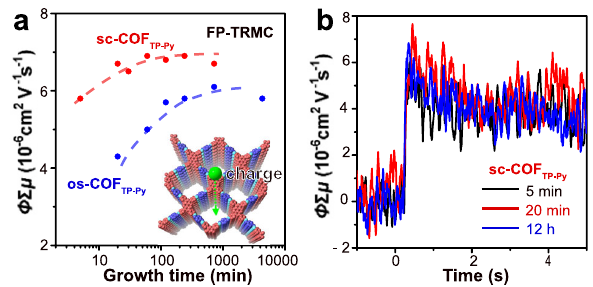
Fig. 6 FP-TRMC measurement. a Photoconductivity ( ϕ Σ μ ) of sc-COF TP-Py and os-COF TP-Py as a function of the growth time. b FP-TRMC transients of the sc-COF TP-Py grown for 5 min, 20 min and 12 h,